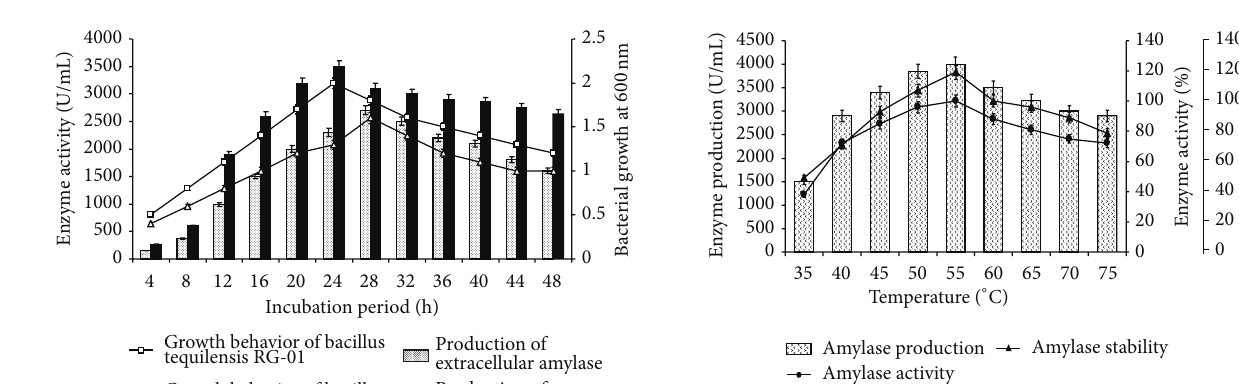
Figure 3: Effect of temperature on amylase production, activity, and stability. The flasks were inoculated with culture in the medium and were incubated at different temperature (35–75 ∘ C) for 24 h at pH 7.0. For enzyme activity, reaction mixture was incubated at different temperatures (35–75 ∘ C) and for stability enzyme was preincubated at respective temperatures for 1h and reaction was conducted as standard assay method. Error bars presented mean values of ± standard deviation of triplicates of three independent experiments.